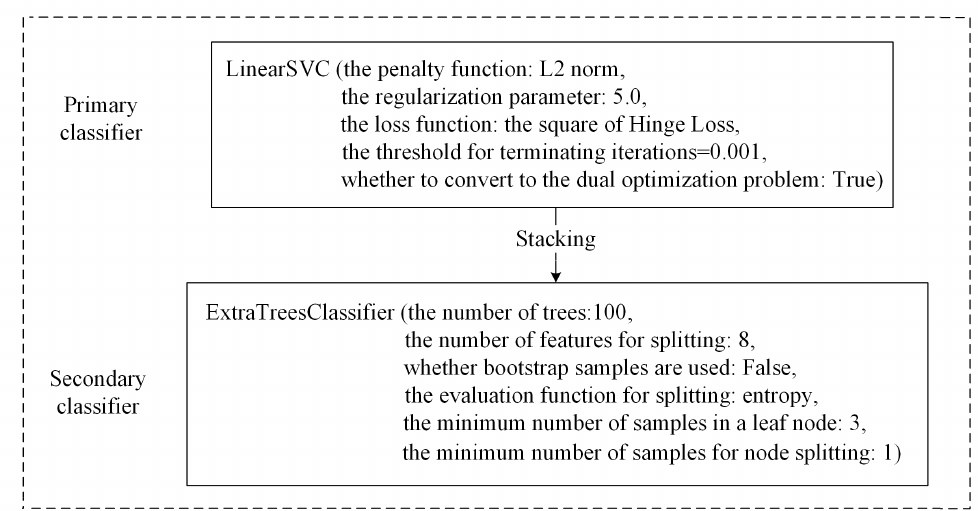
Figure 10. The optimal classification model of the MSVT dataset obtained by GP algorithm.